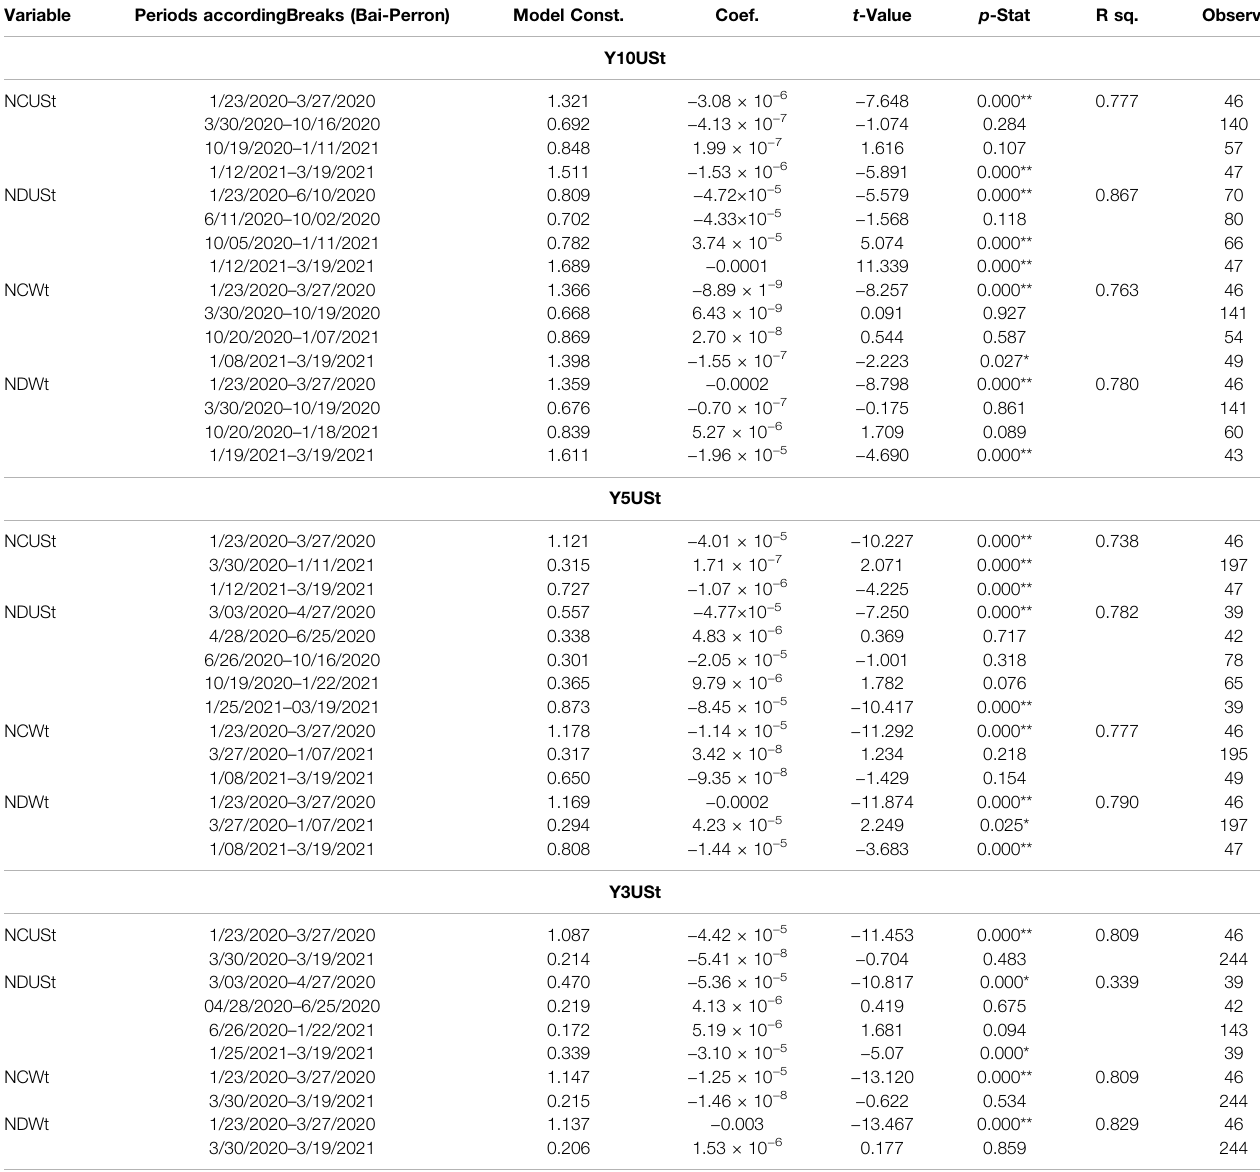
TABLE 3 | Linear regression (Least Squares with Breakpoints) models for COVID-19 impact on the United States government bond yields. Variable Periods accordingBreaks (Bai-Perron) Model Const. Coef. t -Value p -Stat R sq.